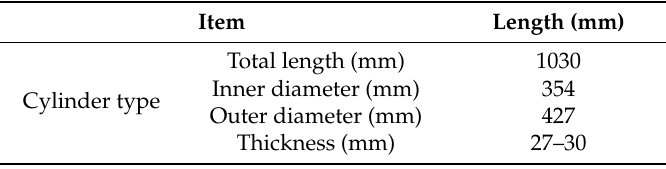
Figure 1. The cross-section of a 74-L Type III hydrogen tank. Table 2. The diameter and dimensions of Type III hydrogen